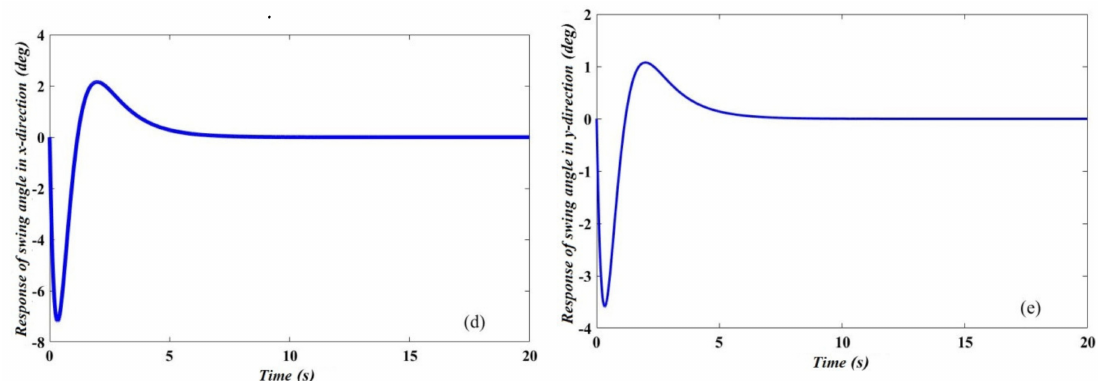
Figure 7. The swing angles when the payload mass is 10